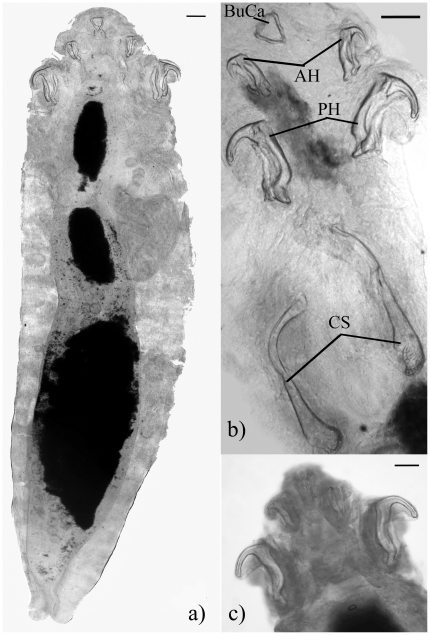
Photographs of Raillietiella frenatus showing key features.(a) Female Raillietiella frenatus (bearing morphological resemblance to Raillietiella indica) from Rhinella marina showing entire specimen. Note sharp anterior hooks and intermediately sharp posterior hooks. Photograph is complied from five images stitched longitudinally together. (b) Anterior view of male R. frenatus from Hemidactylus frenatus, note buccal cadre (BuCa), sharp anterior hooks (AH), relatively blunt posterior hooks (PH) and copulatory spicules (CS). (c) Anterior view of female R. frenatus from H. frenatus, note blunt posterior hooks. Scale bars are all 0.1 mm.